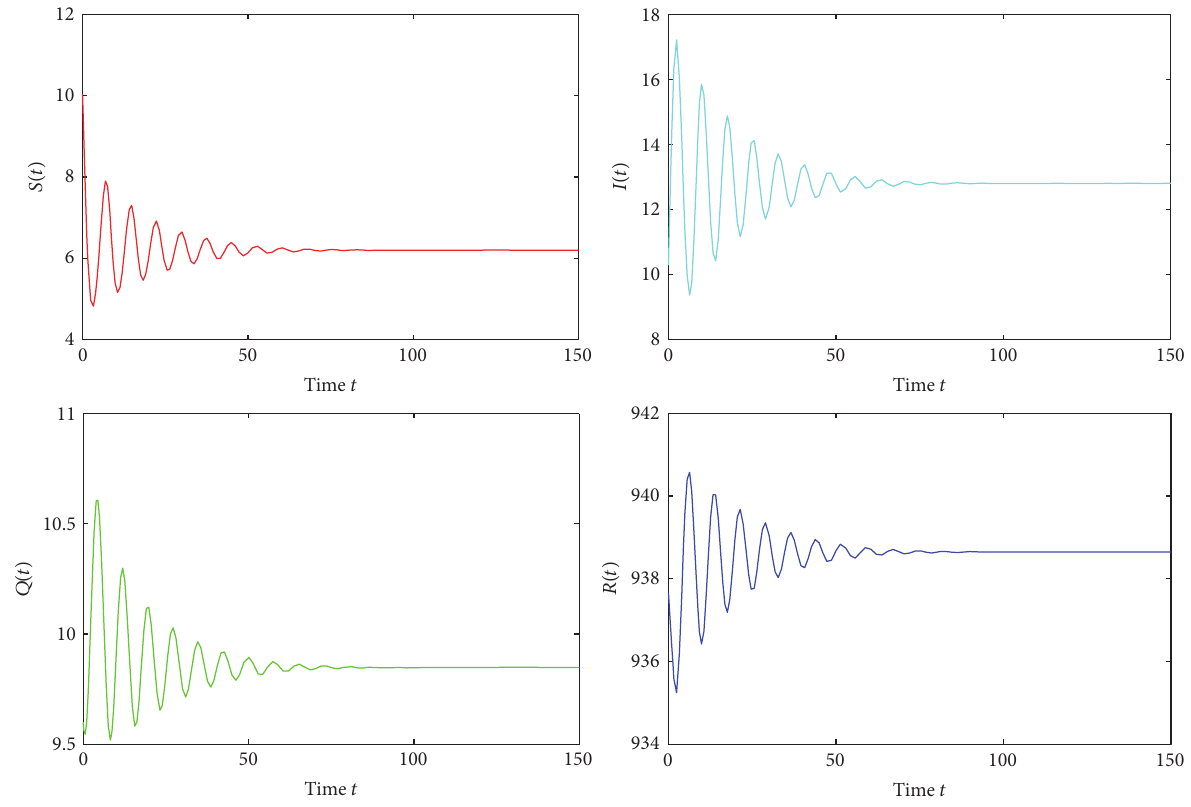
Figure 7: The trajectory of 𝑆 , 𝐼 , 𝑄 , and 𝑅 when 𝜏 2 = 1.65 < 1.7852 = 𝜏 20 .